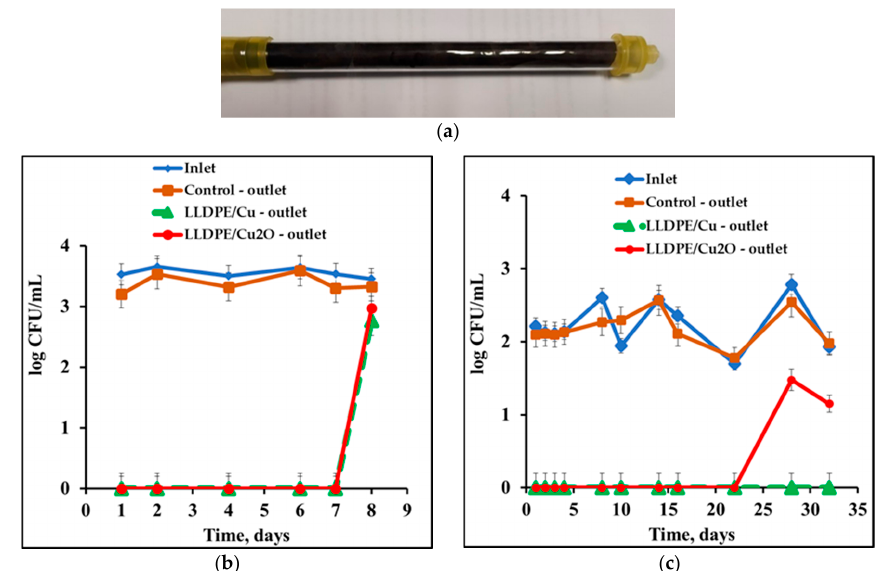
Figure 8. Antibacterial effect of CuNPs and Cu 2 ONPs immobilized onto LLDPE rolled into a column ( a ) against S. aureus ( b ) and E. coli ( c ) cells in a continuous regime. Cell concentration was measured at the inlet to the system and at the outlets of the columns with LLDPE/CuNPs and LLDPE/Cu 2 ONPs composites, and from a control column.